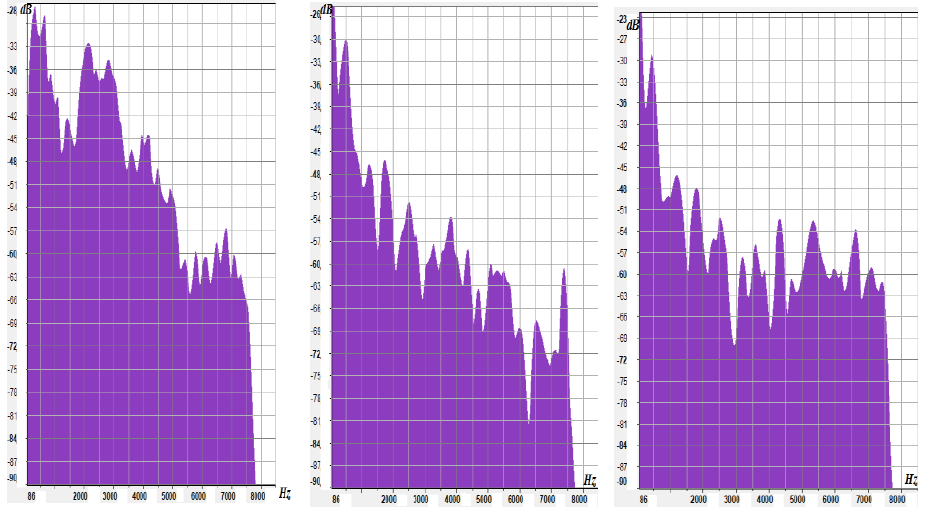
Fig. 1. Spectral characteristics for the phrase "Preflight communication check" recorded by different